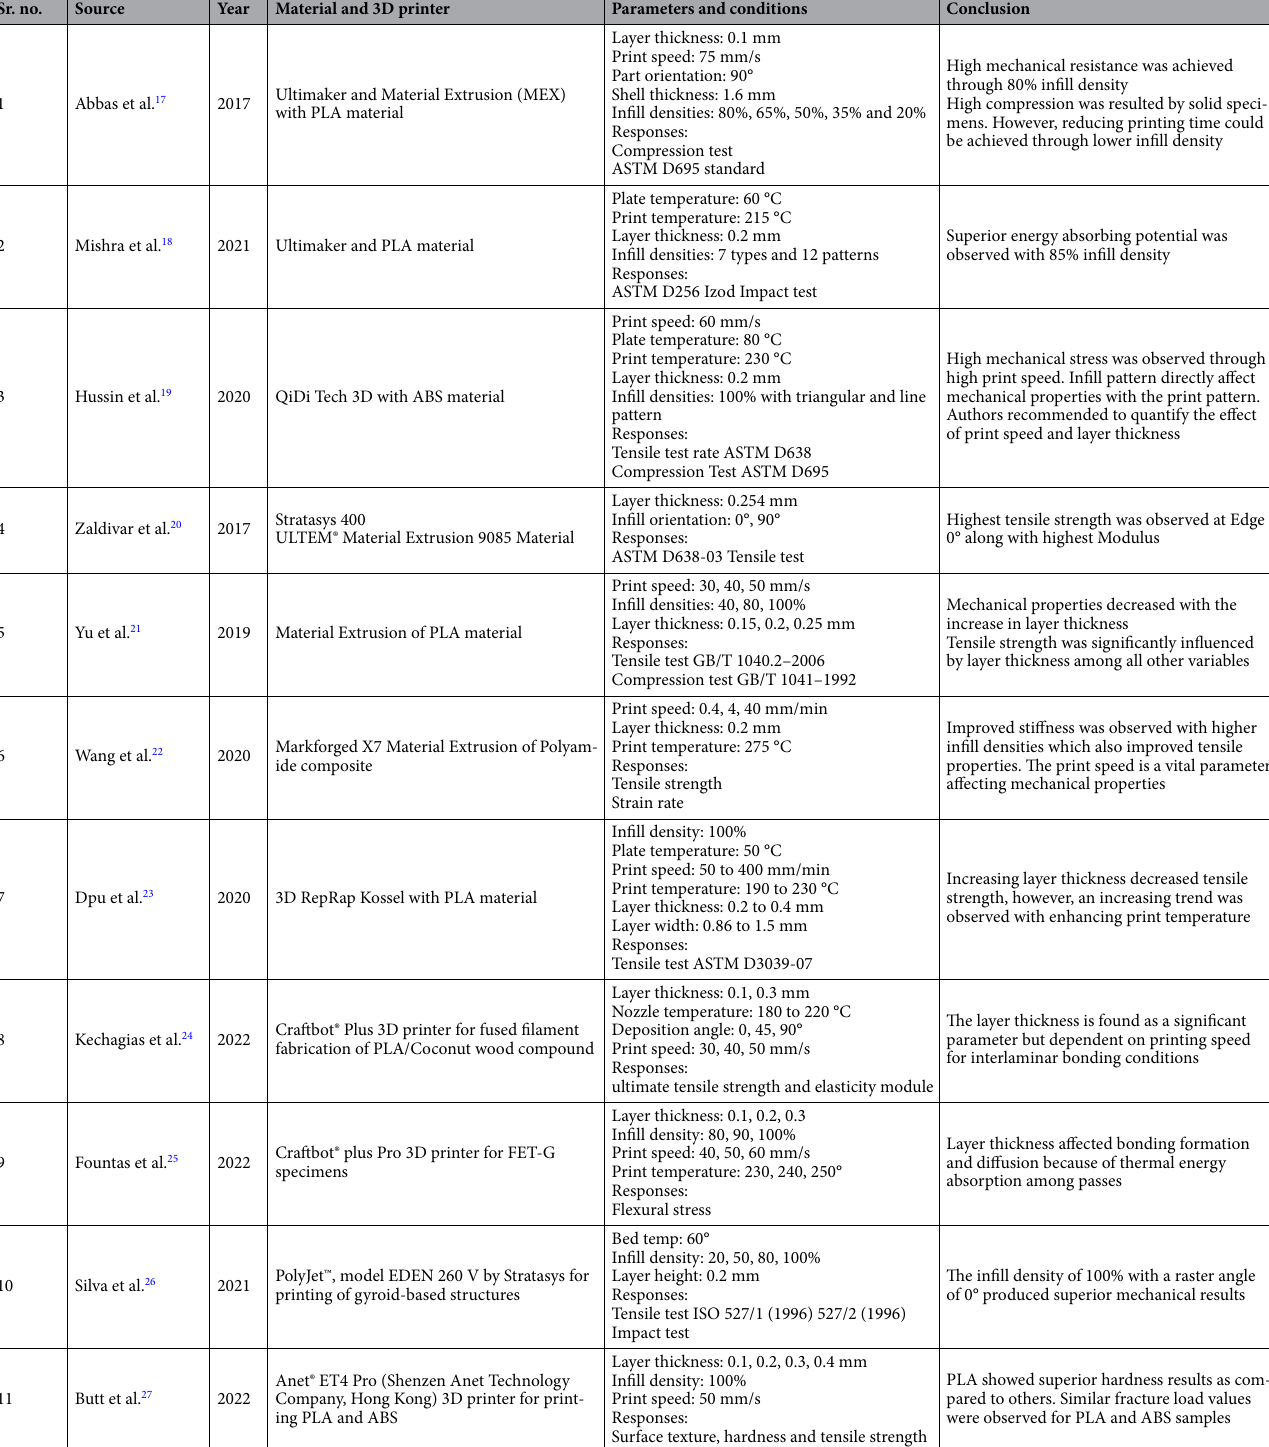
Table 1. A comprehensive overview of MEX input parameters and their effect on different responses as reported in